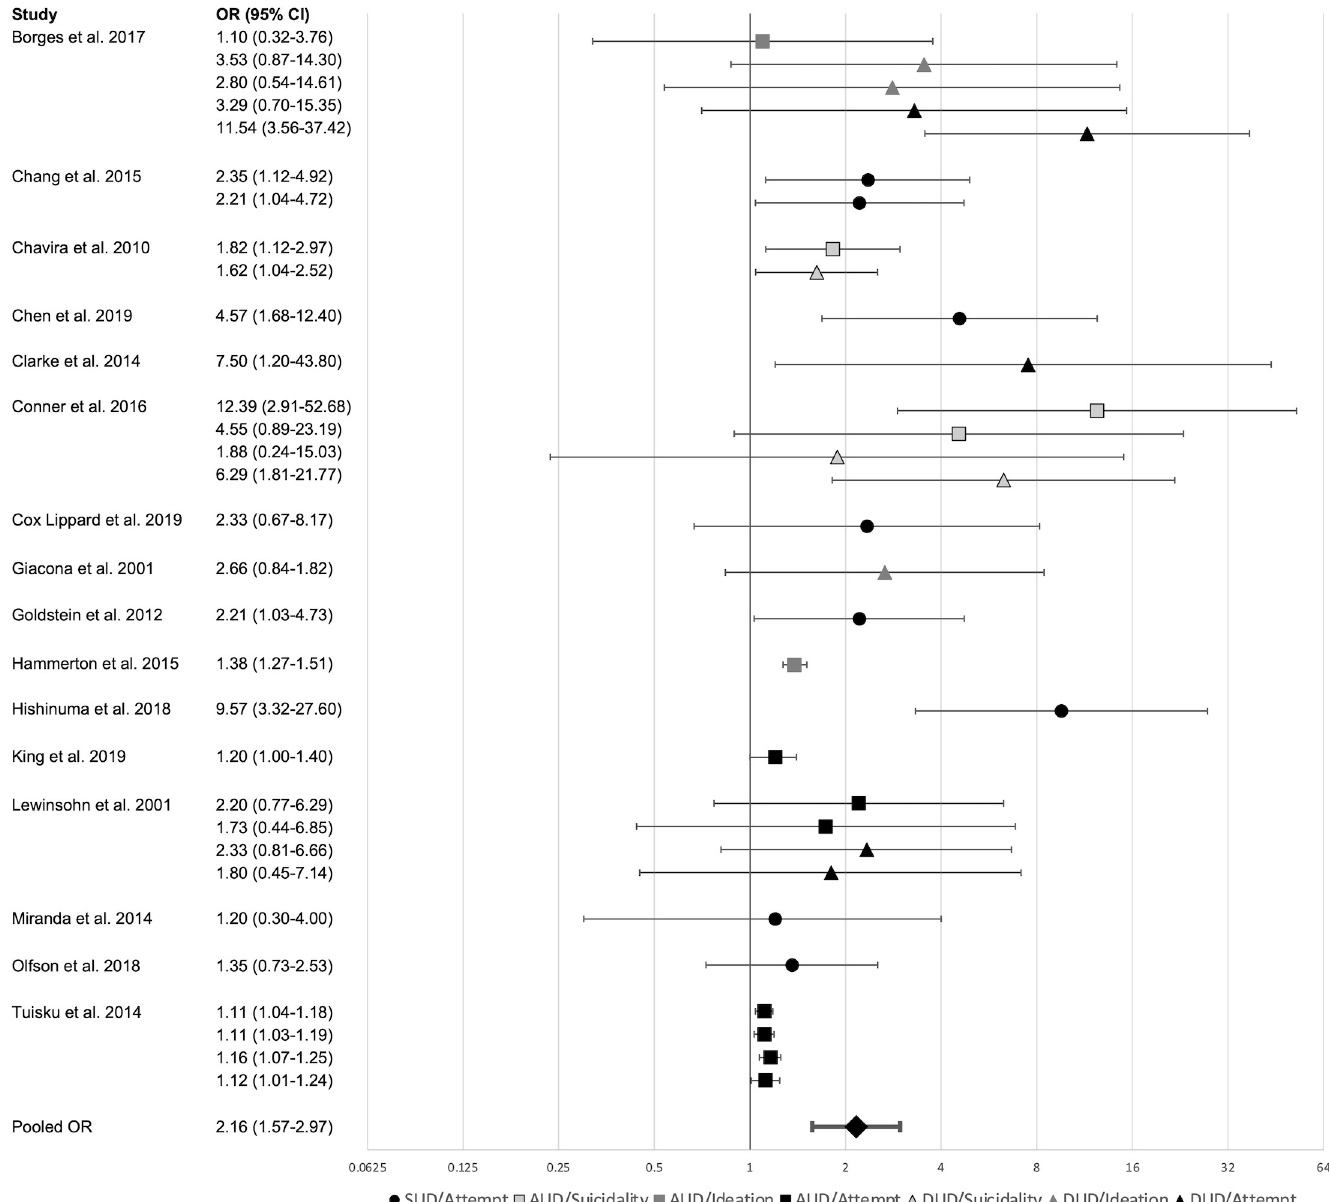
Fig 2. Secondary psychiatric disorder hypothesis forest plot. Markers represent effect sizes, bars represent the 95% confidence interval. Pooled OR based on three- level random effects